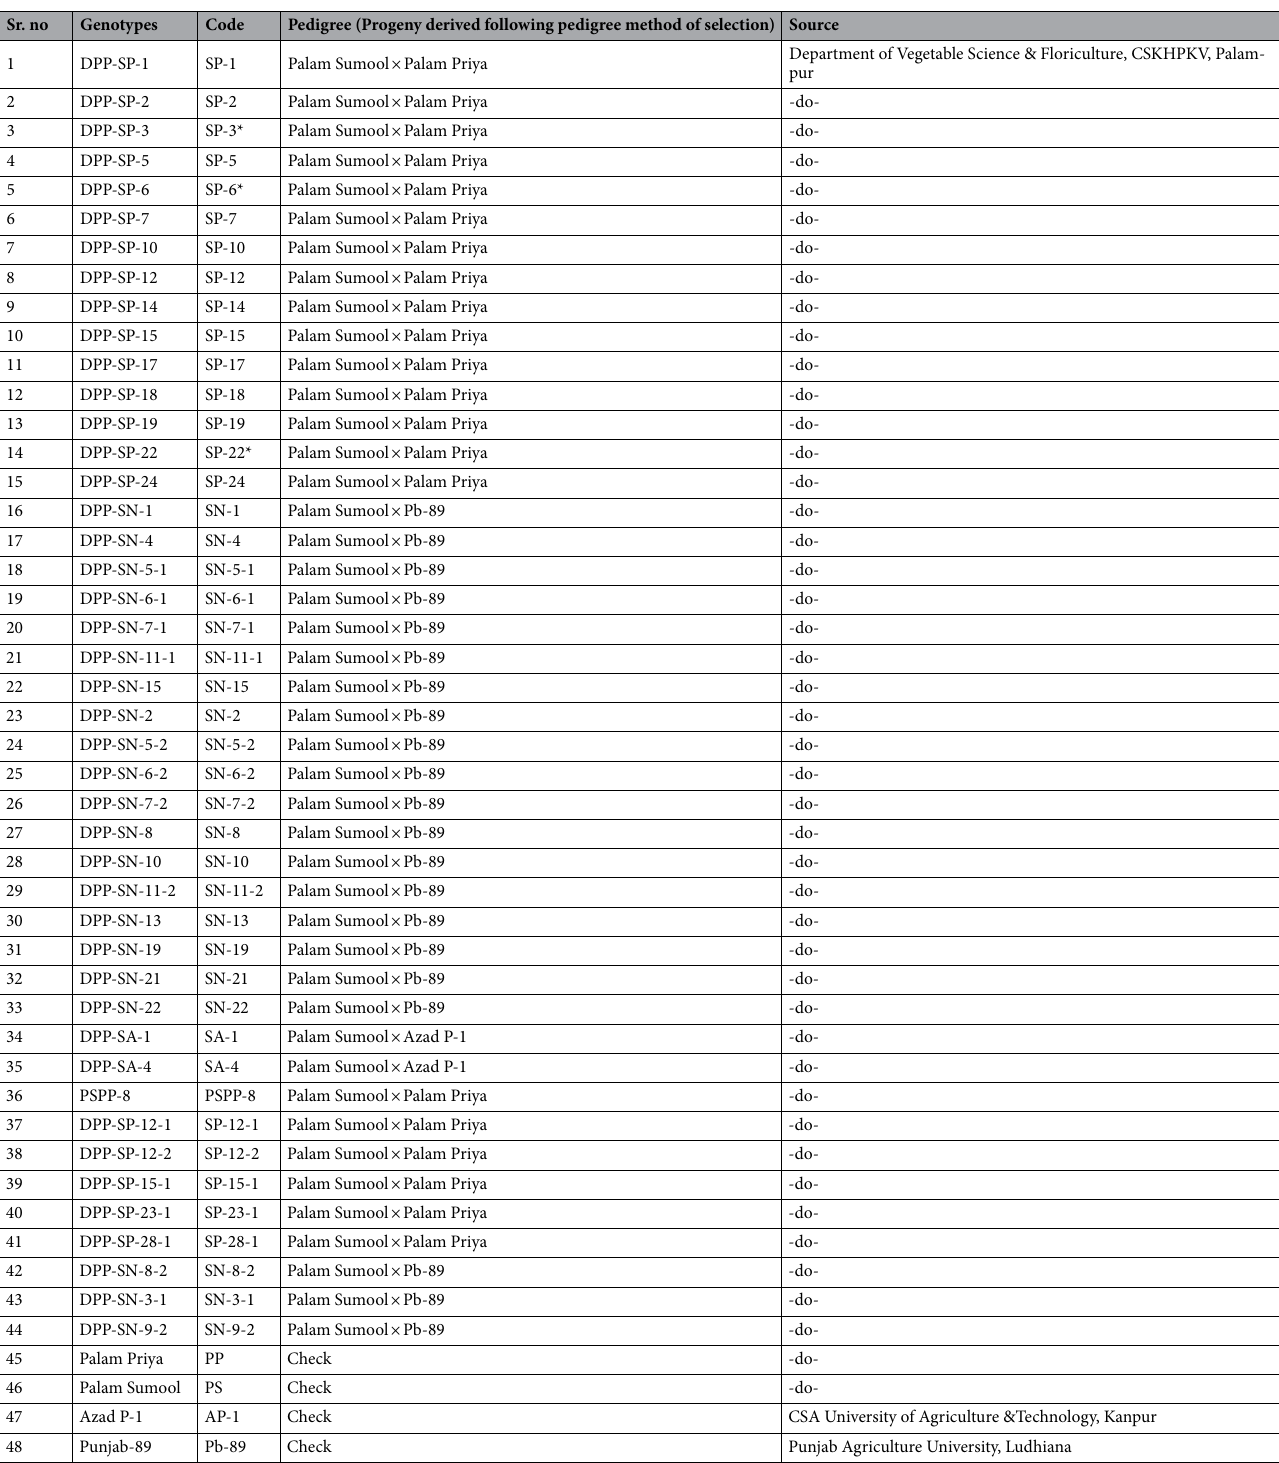
Table 1. Genotypes of experiments and their source. * High yielding